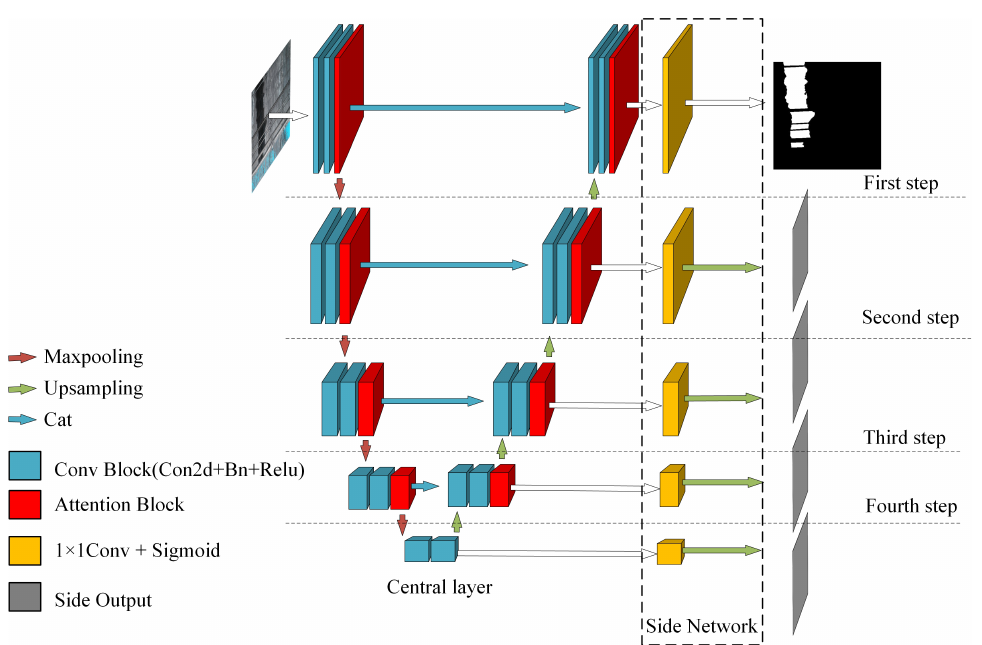
Figure 1. The architecture of the atrous channel pyramid attention network